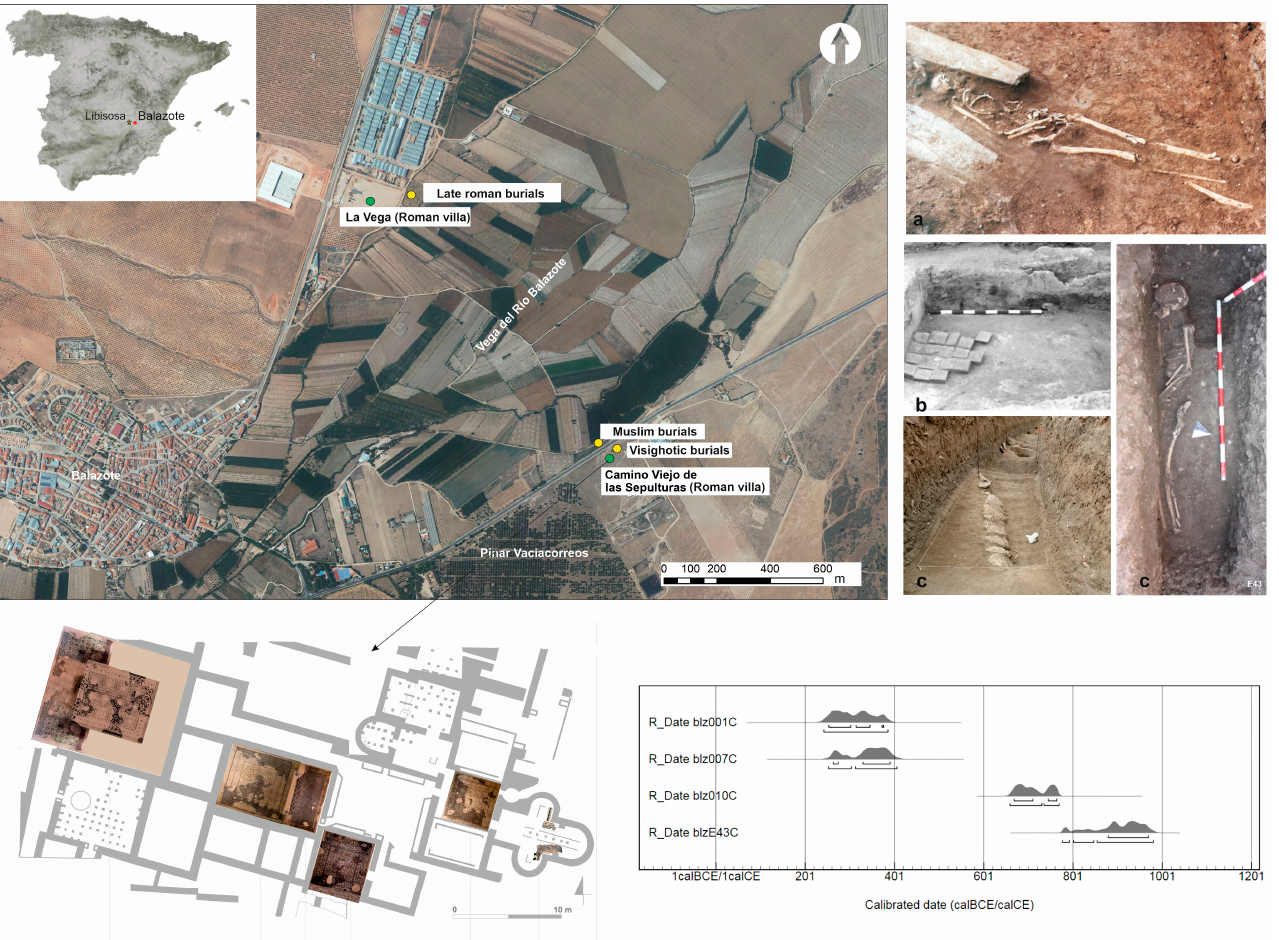
Figure 9. The locations of the different sectors of the CVS site. The right-hand panel shows details of the Late Antiquity ( a ) and Islamic ( c ) funerary uses and some combustion structures ( b ) that transformed the functionality of the original roman villa in the 5th century. The bottom panels show a plan of the pars urbana of the villa during its phase of splendour and the radiocarbon dating of several burial sites in the post-classical necropolis.